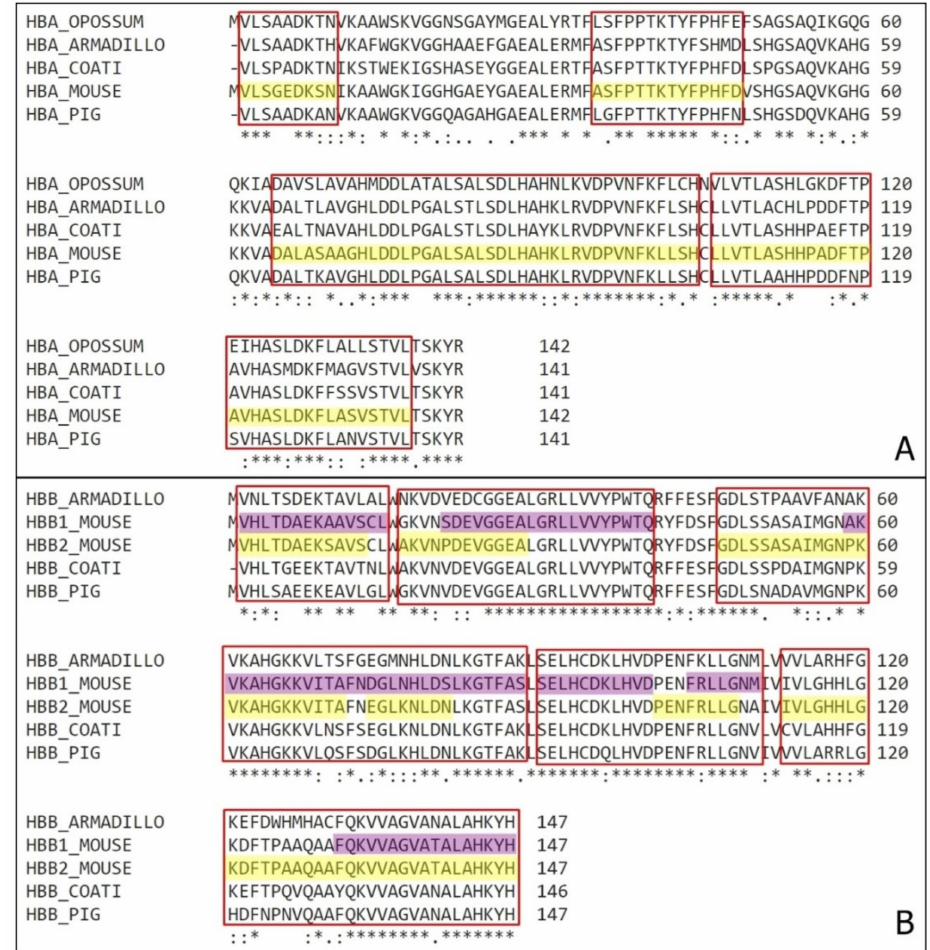
Figure 7. Natural reservoirs organisms’ hemoglobin comparison. ( A ) Comparison of α hemoglobin subunit from Mus musculus (HBA_MOUSE) with Monodelphis domestica (HBA_OPOSSUM), Dasypus novemcinctus (HBA_ARMADILLO), Nasua nasua (HBA_COATI) and Sus scrofa (HBA_PIG). Highlighted in yellow are the antimicrobial fragments identified on this work, and marked on red are the correspondent sequences on the other animals. ( B ) Comparison of β hemoglobin subunit from Mus musculus (HBA_MOUSE) with Dasypus novemcinctus (HBA_ARMADILLO), Nasua nasua (HBA_COATI) and Sus scrofa (HBA_PIG). Highlighted in yellow are the antimicrobial fragments of β 1 chain and in purple are the fragments of β 2 chain identified on this work, and marked on red are the correspondent sequences on the other animals. (*) – position with a single and fully conserved amino acid residue; (:) – position with amino acid residues conserved between groups of strong similar properties; (.) – position with amino acid residues conserved between groups of weakly similar